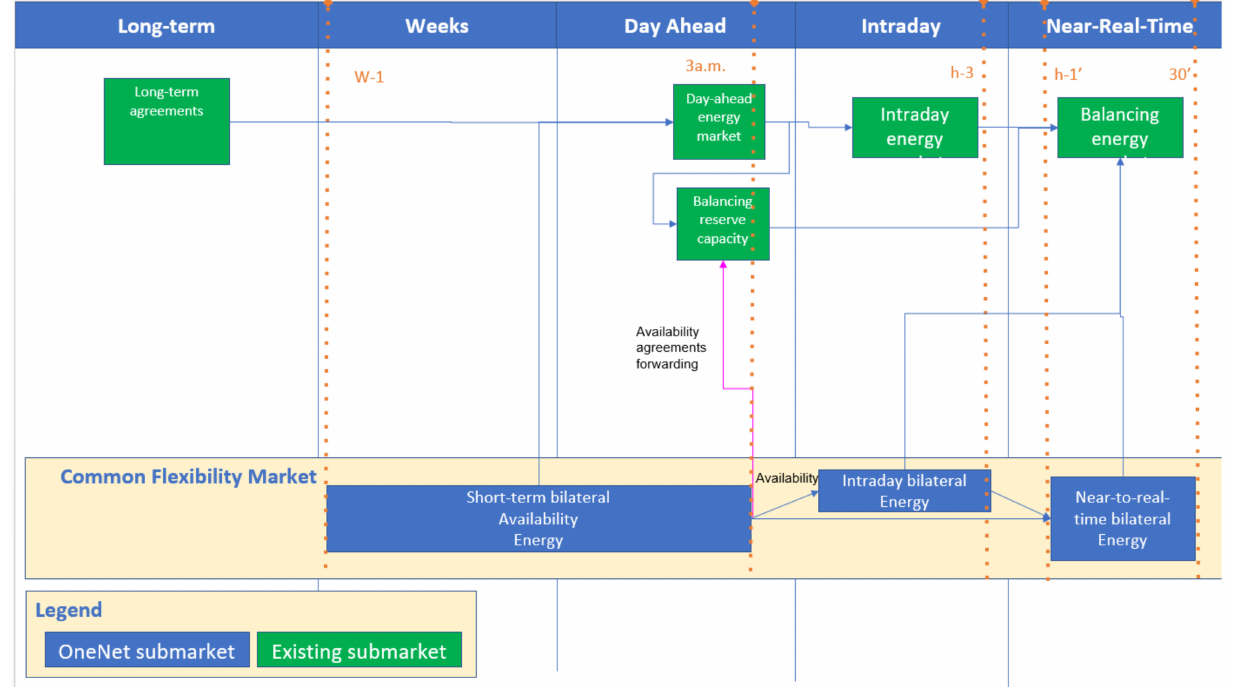
Figure 5. Visualization in a high level of the pilot project in